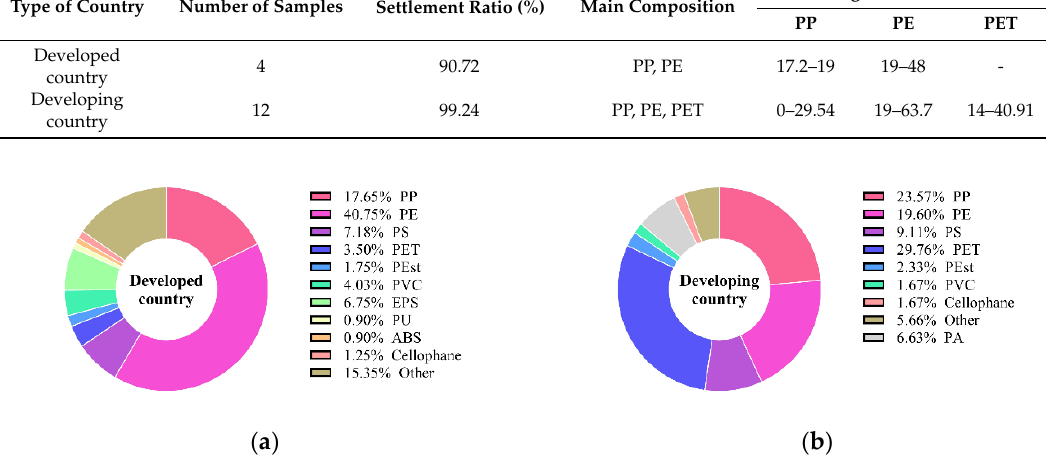
Figure 3. Average percentage composition of microplastics: ( a ) in developed countries; ( b ) in developing countries. Polyamide (PA), polyvinyl chloride (PVC), expanded polystyrene (EPS), polyurethane (PU), and acrylonitrile butadiene styrene plastic (ABS).